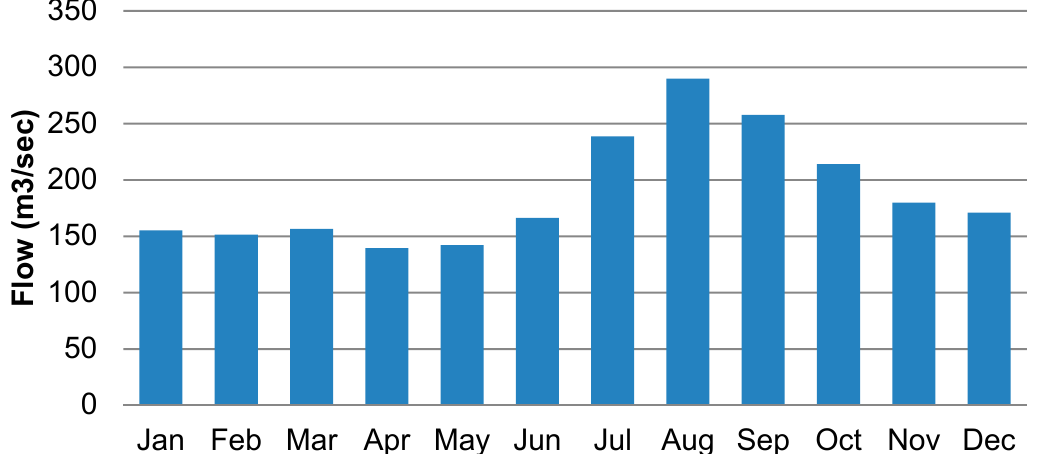
Figure 3. Seasonal distribution of flow recorded after Dukan Dam.